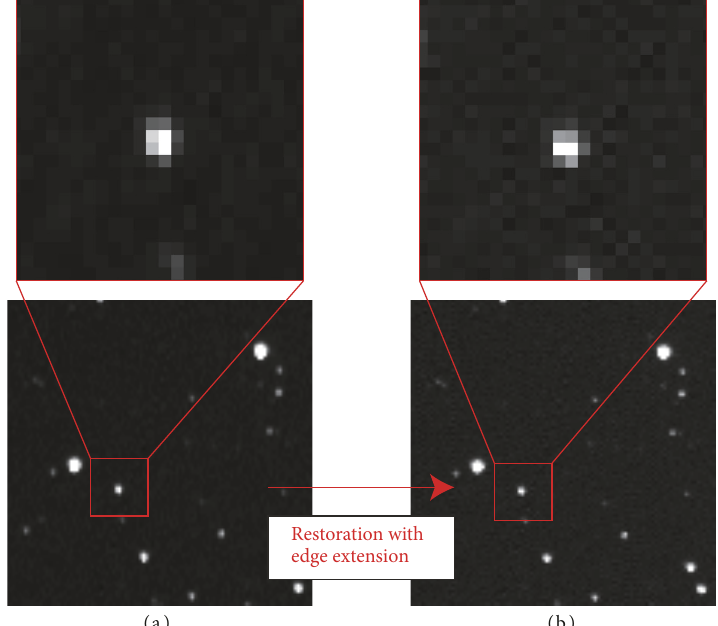
Figure 6: Experimental result when zenith angle is 30 ∘ . (a) The original image stars. (b) The corrected image